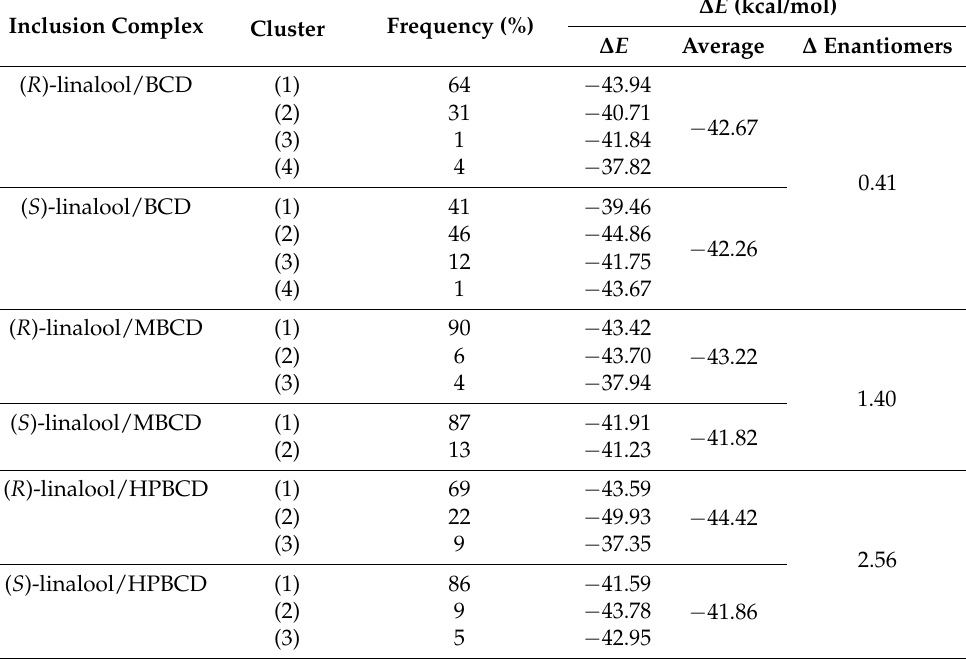
Table 5. The percent frequency occurs in docking calculation, the complexation energy ( ∆ E ) of each inclusion complexes cluster, the average complexation energy values of enantiomeric linalool/BCD complexes, and the difference between complexation energy of ( R )- and ( S )-enantiomers ( ∆ enan- tiomers) using PM7